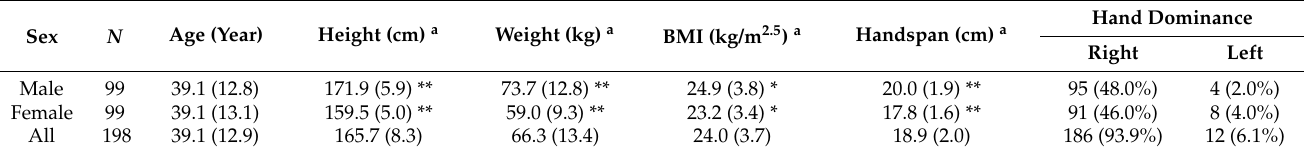
Table 1. Demographic and anthropometric characteristics of volunteers by sex. Values shown are mean/count (standard deviation/percent).